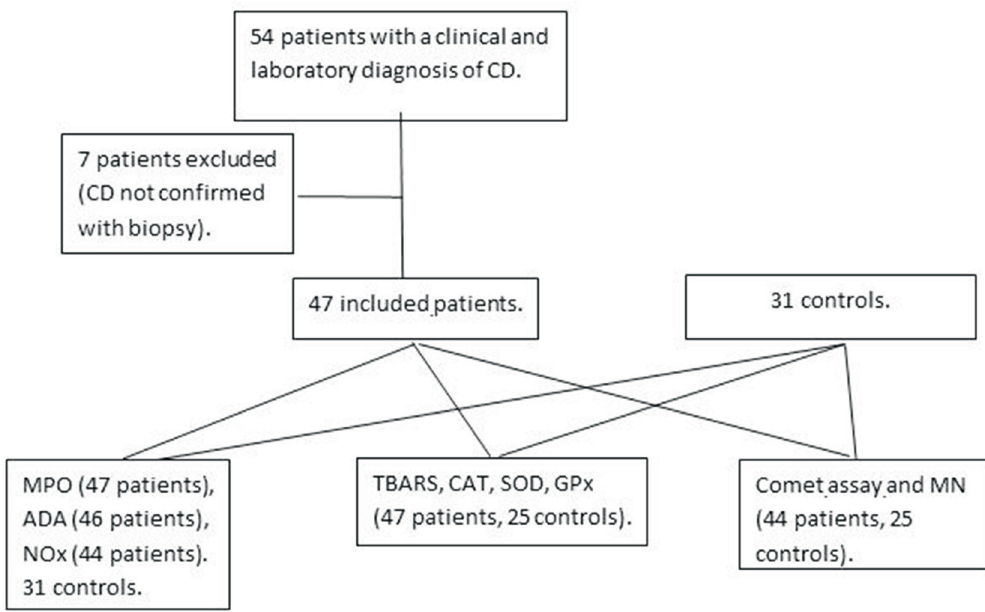
Figure 1 - Study flow